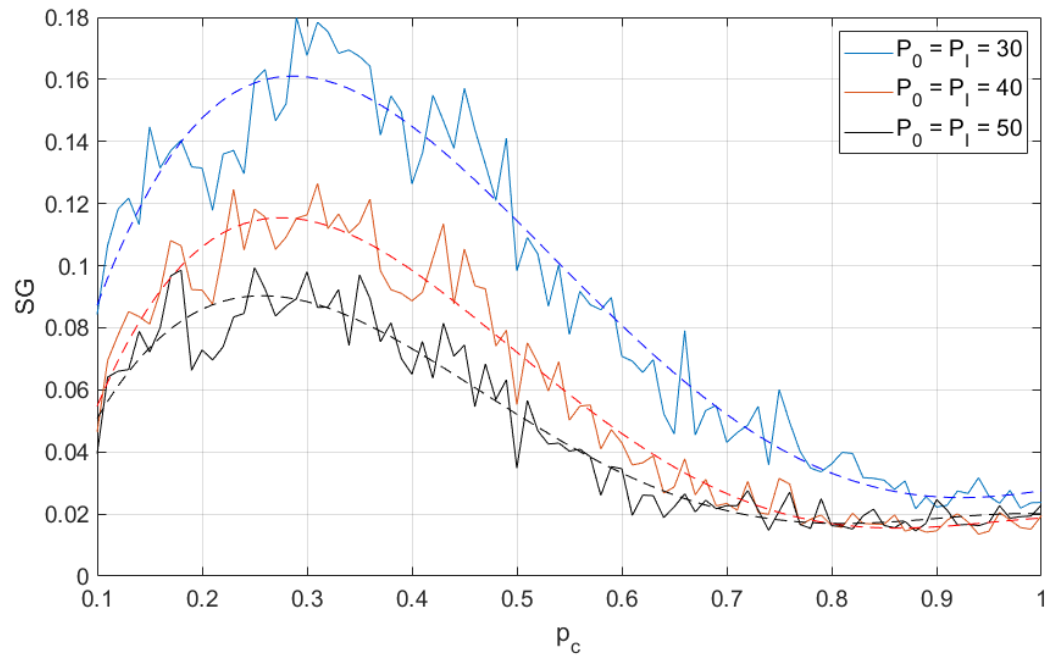
Figure 3. Second largest cluster size as function of node operation probability (different transmit power levels); 30 neuron-nodes. Dashed lines are a fourth-degree polynomial approximation.